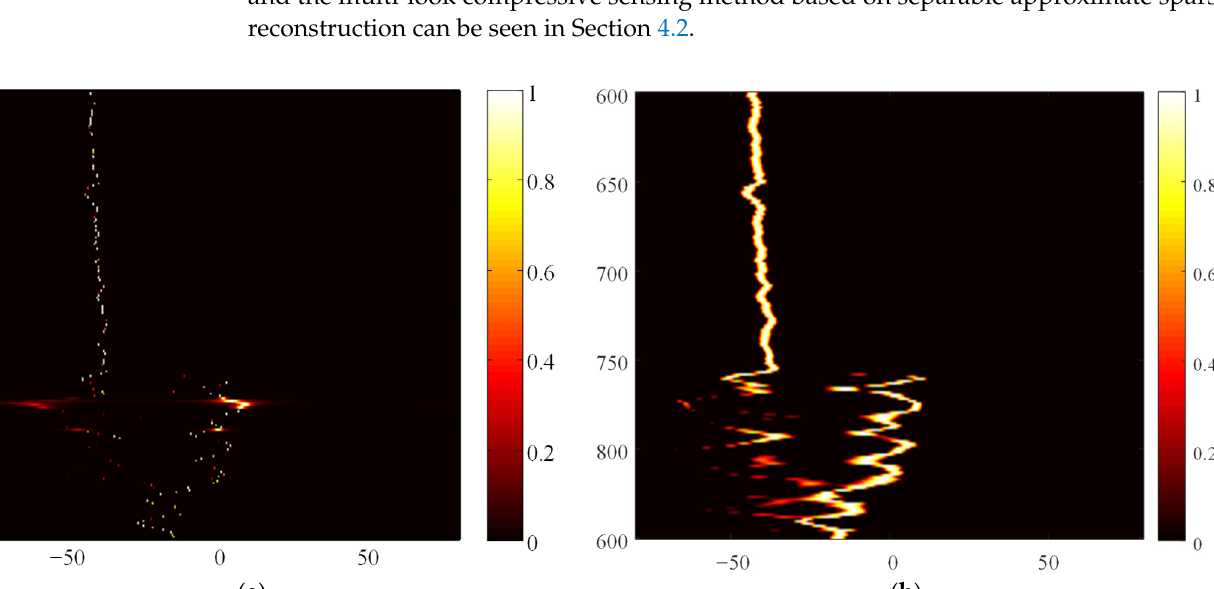
( b ) Figure 9. Height distribution of scattering points. ( a ) Multi-look compressive sensing method; ( b ) Separable approximate sparse reconstruction algorithm. The horizontal axes represent pixels from 600 to 800 in the slant range, and the vertical axes are heights in the elevation direction with the unit m.